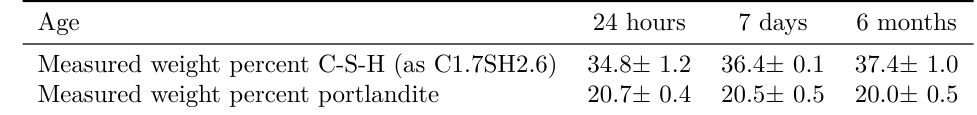
Table 2. XRD measurements with fully hydrated activated